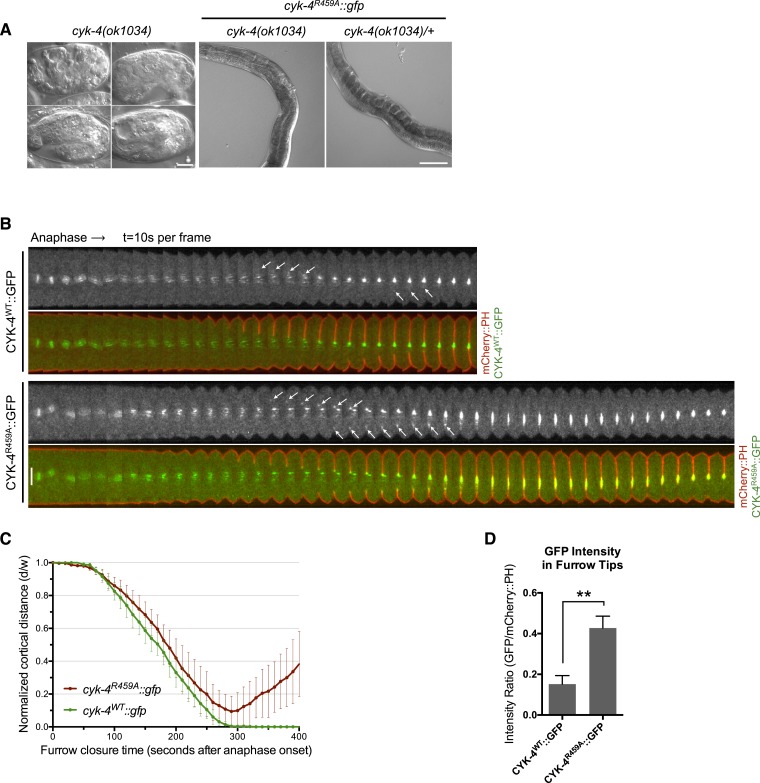
CYK-4 GAP activity is required for cytokinesis and viability.(A) cyk-4(ok1034) null embryos arrest at variable stages during embryogenesis (left). The GAP-deficient CYK-4R459A transgene rescues the embryonic lethality, but animals arrest as sterile adults (middle). GAP-deficient CYK-4R459A is recessive, no phenotypes is seen in the presence of cyk-4(+) (right). Right scale bar 50 µm. (B) GAP-deficient CYK-4R459A embryos fail to complete cytokinesis. Kymographs are generated as in Figure 1D, with the exception that the signal from the CYK-4 transgenes is also shown (green), overlaid on mCherry::PH (red). CYK-4R459A accumulates more strongly at furrow tips as compared to CYK-4WT (arrows). (C) The kinetics of furrow ingression in CYK-4WT and CYK-4R459A embryos. Results are quantified as described in Figure 1G. (D) Membrane accumulation of CYK-4WT and CYK-4R459A. Results are quantified as described in Figure 1B (**p < 0.01, by t-test).